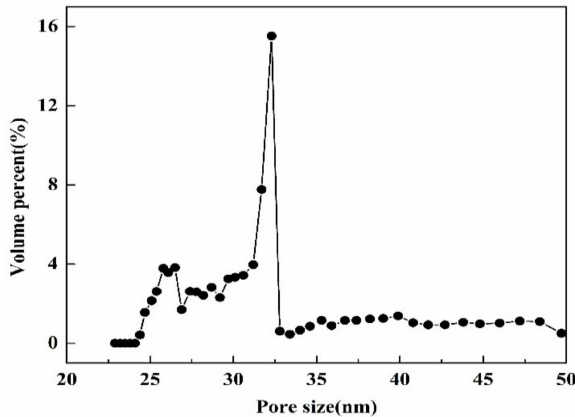
Figure 3. Pore size distribution of α -Al 2 O 3